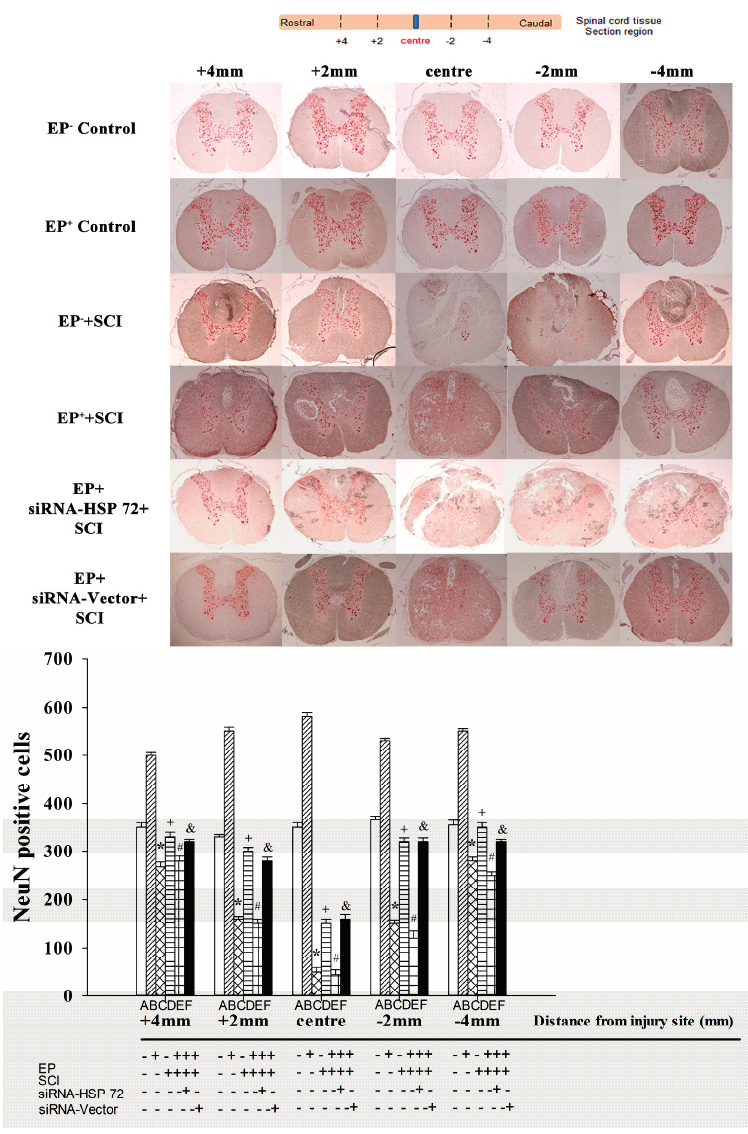
2.6. Post-Laminectomy Underexpression of Gray Matter Neuronal and Astroglial HSP 72 An immunofluorescence assay 7 days post-laminectomy was used to assess the effect of SCI-induced of neuronal and astroglial HSP 72 in the injured spinal cord. The number of NeuN + HSP 72 double-positive cells (Figure 7a) and of GFAP + HSP 72 double-positive cells (Figure 7b) was calculated and summed. EP + Control group rats had significantly more NeuN + HSP 72 double-positive cells (Figure 7a) and more GFAP + HSP 72 double-positive cells (Figure 7b) than did the EP − Control